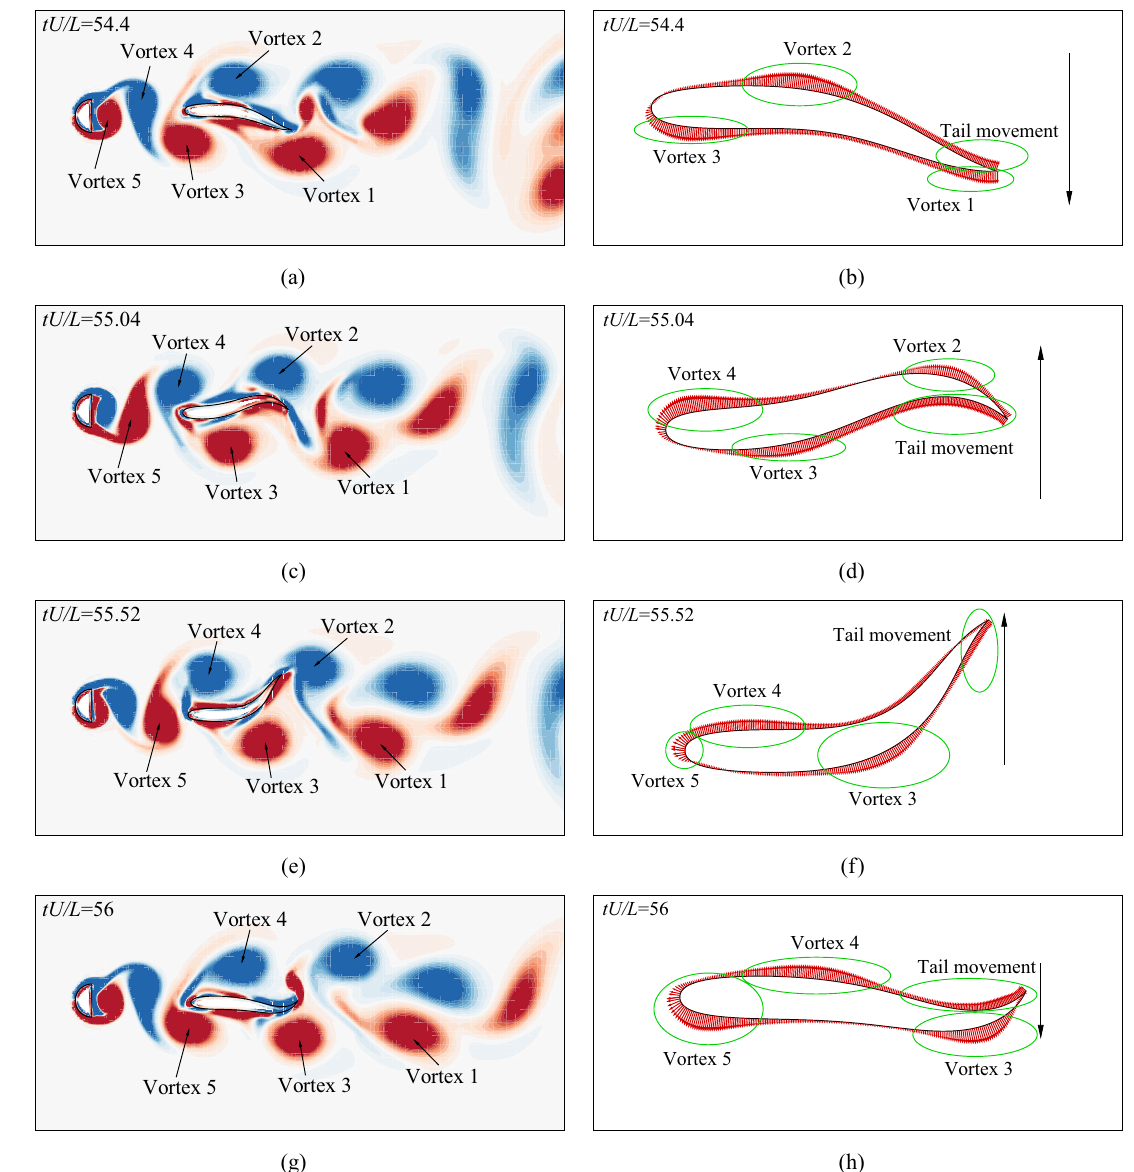
Figure 18. Vorticity contours and pressure distributions on the body surface when the fish is holding 54.4 , ( b ) pressure at tU / L 54.4 , ( c ) vorticity at position in the Kármán vortex street: ( a ) vorticity at tU / L = = 55.04 , ( d ) pressure at tU / L 55.04 , ( e ) vorticity at tU / L 55.52 , ( f ) pressure at tU / L 55.52 , ( g ) tU / L = = = = 4 to 4. Flow 56 , and ( h ) pressure at tU / L 56 . The range of the vorticity contours is from vorticity at tU / L − = = visualization is achieved by using Tecplot 360 EX 2015 R2 (https ://www.tecpl